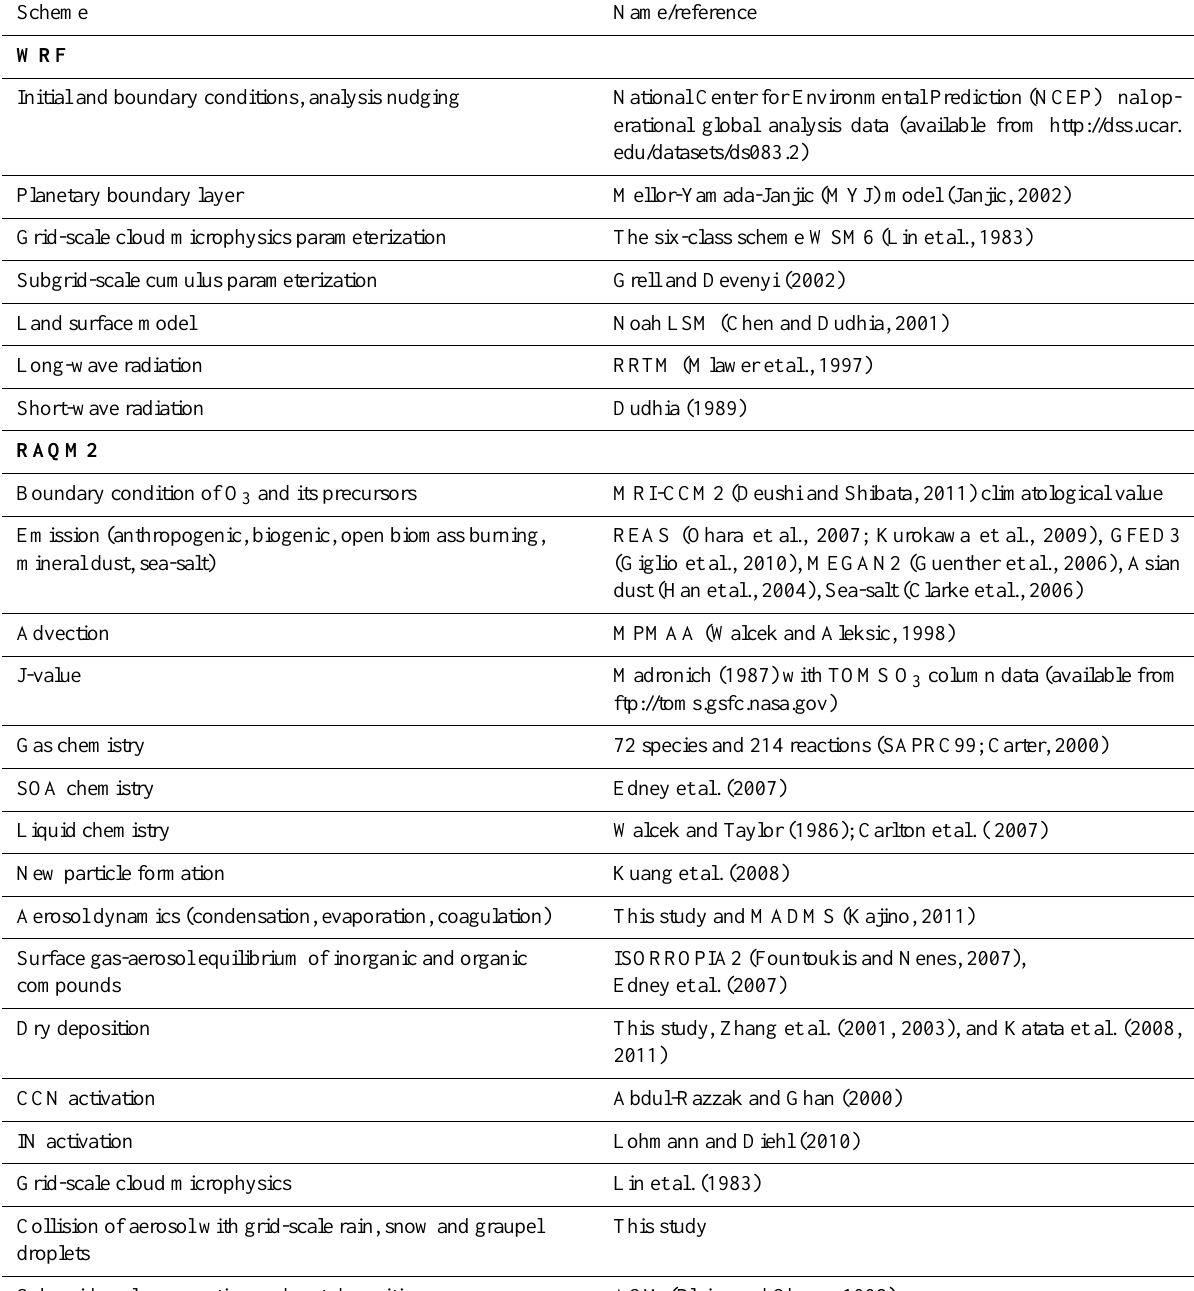
Table 1. List of data and schemes used in the WRF and RAQM2 models.